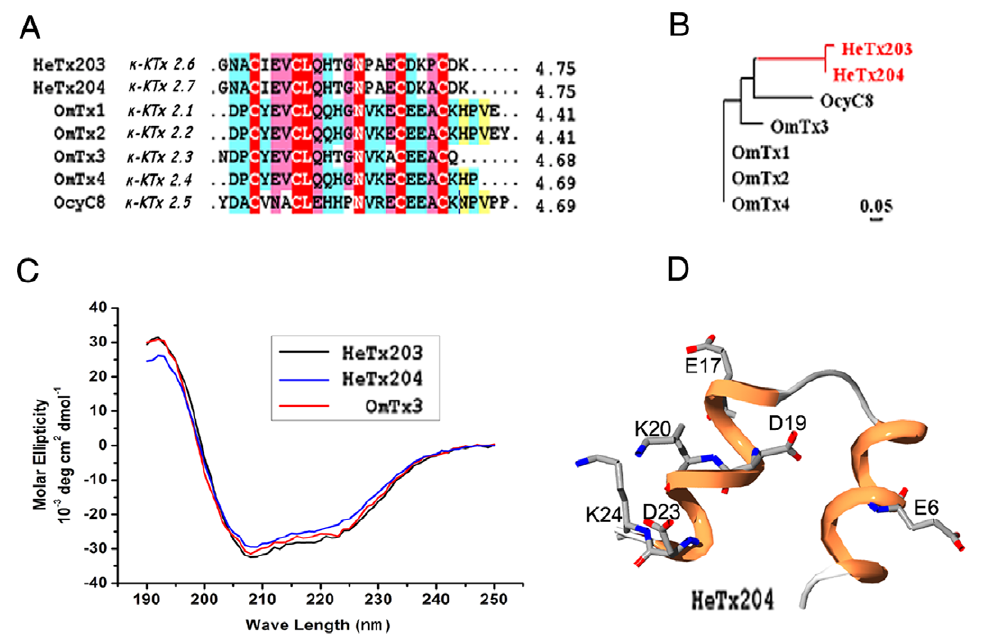
Figure 4. Two new members of the kappa-KTx2 subfamily. (A) Multiple sequence alignment of HeTx203 (kappa-KTx2.6) and HeTx204 (kappa- KTx2.7) with other kappa-KTx2 members; (B) Phylogenetic tree of two new kappa-KTx2 toxins with other members; (C) Circular dichroism spectra of HeTx203, HeTx204, and OmTx3; (D) Model structure of HeTx204 with OmTx3 as a template.